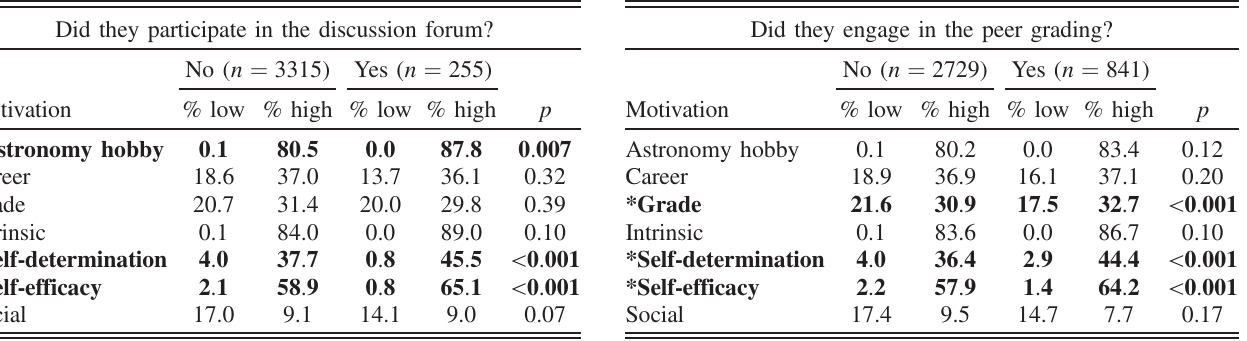
TABLE VII. Percentages of learners in the low and high tiers of each motivational category for those who did not participate in the forum and for those who did. Statistically significant results at the p ¼ 0 . 05 level using the Kolmogorov-Smirnov two sample test are denoted with asterisks and in bold type.